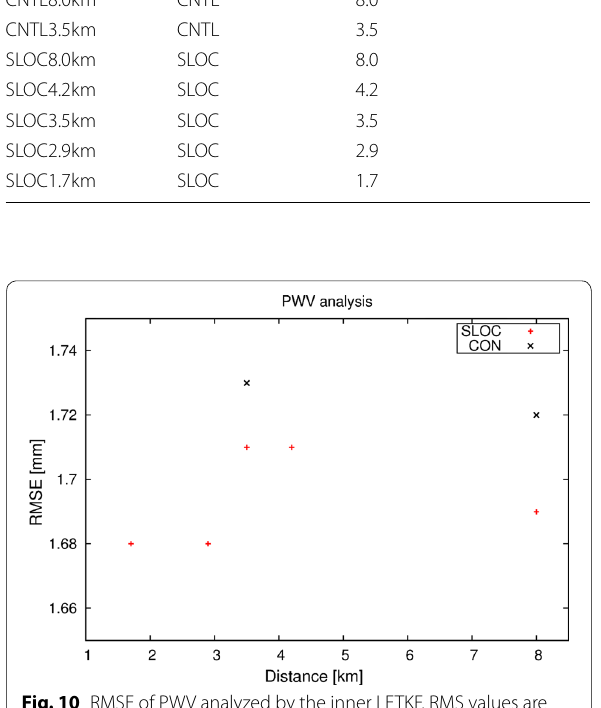
Fig. 10 RMSE of PWV analyzed by the inner LETKF. RMS values are averaged during 0200–0600 LT on August 14, 2012. Experiments indicated by the plus symbols are assimilated PWV SPD-H with the SLOC localization setting. Experiments indicated by the cross symbols are assimilated PWV CON with the CNTL localization setting. The GNSS- PWV SPD-H data used to evaluate RMSEs were observed at the 10 stations shown in Fig. 1b, which are the same data assimilated in the SLOC experiment with the mean inter-station distance of 1.7